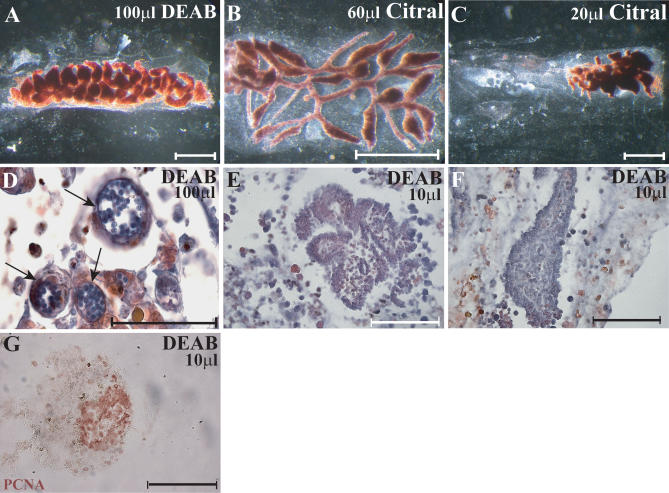
Specific RA Inhibitors, DEAB and Citral, Inhibit Bud RegenerationEarly stages of bud regeneration were blocked by different concentrations of RA inhibitors. With the administration of 100 μM of DEAB, vessel coalescence gradually slowed down and stopped completely after day 2 (A). Similar results were obtained with 60 μM of Citral (B), while with 20 μM of the same inhibitor ampullae changed orientation and migrated within the tunic but never regenerated a functional zooid (C). At the 100 μM DEAB concentration, buds had not developed, and multinucleated giant cells appeared, scattered throughout the vessel lumen (D, arrows). At the 10 μM DEAB concentration, morphologically abnormal buds were formed, which failed to develop organ structures, and retained a simple epithelial morphology (E). In severe cases, masses of undifferentiated aggregated cells occupied the interior of the vessel lumen (F). All malformed buds subsequently degenerated. PCNA immunostaining revealed distinctive proliferations at aggregated masses while no staining was detected in blood vessels (G). Scale bar in (A–C) represents 1 mm. Scale bar in (D–G) represents 100 μm.